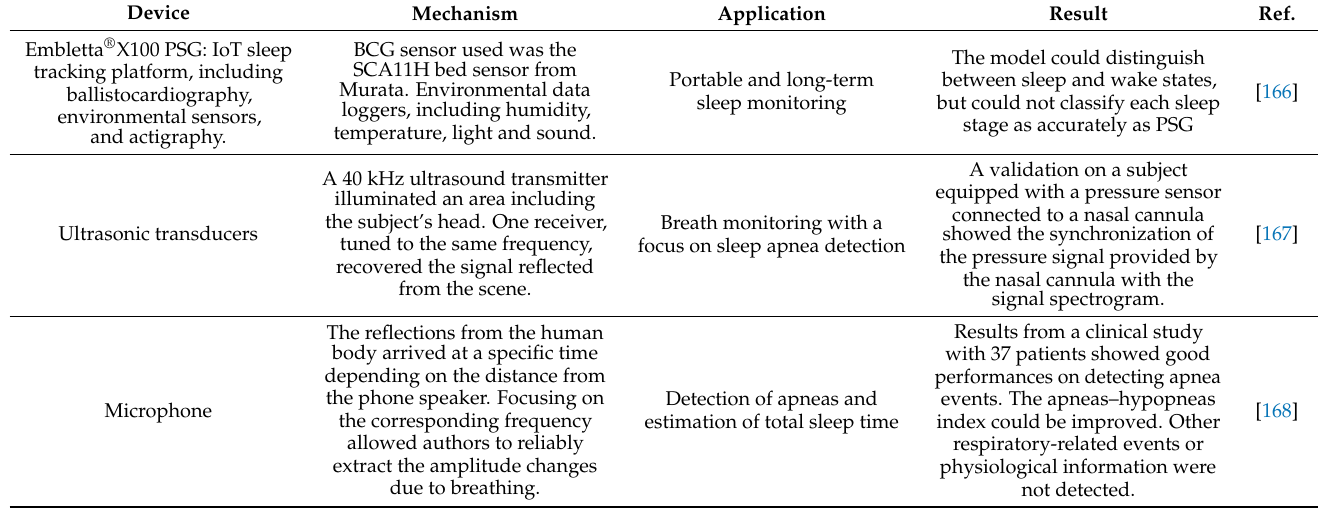
Table 7. Unobtrusive sleep monitoring solutions which exploit acoustic